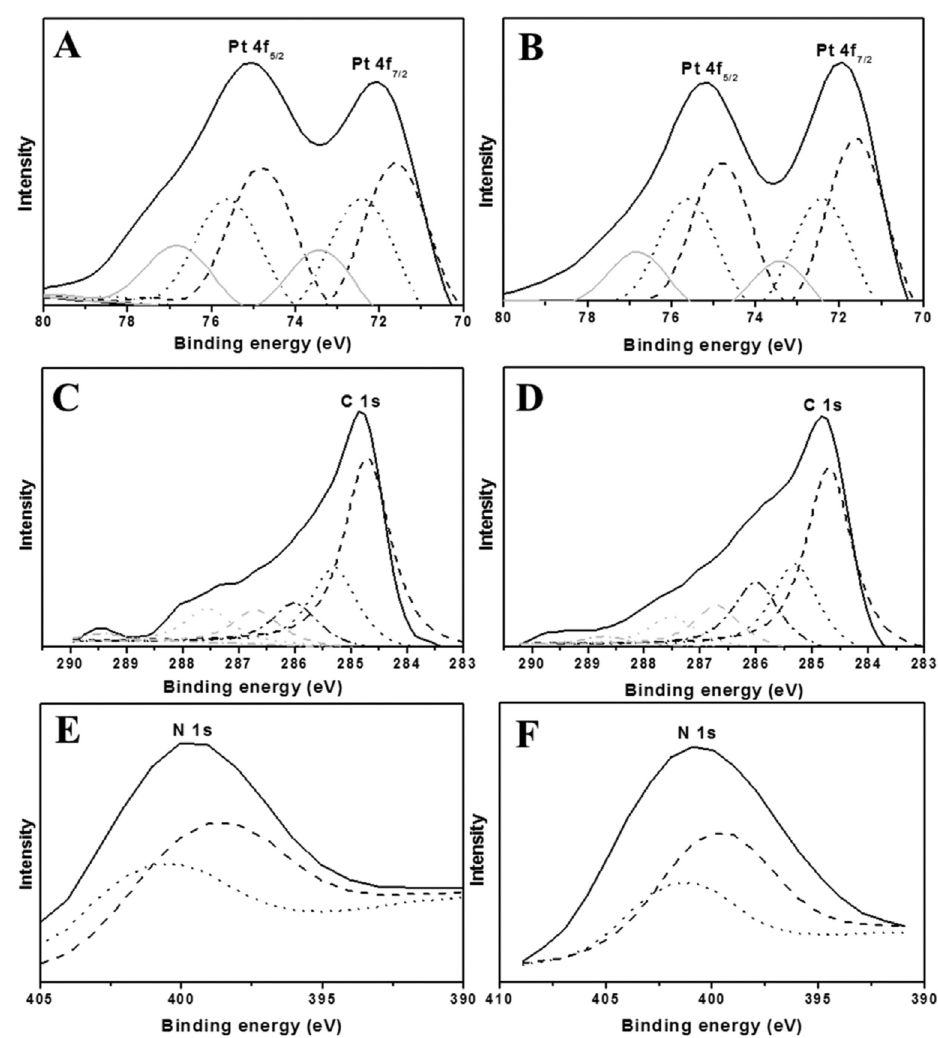
Figure 2 . XPS spectra displaying the Pt 4f (A and B), C 1s (C and D), and N 1s (E and F) energy levels of the Pt/[BMIM][PF 6 ]/CNT (A, C, and E) and Pt/[BMIM][Cl]/CNT (B, D, and F)